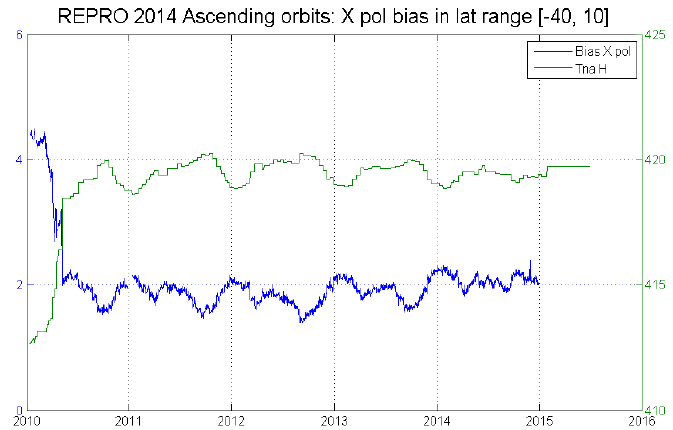
Figure 2. Bias of the Xpol SMOS measurements for ascending orbits over the Pacific Ocean (blue) for the period 2010–2015 and the NIR calibration parameter Tna (green). A computation of the correlation factor between the two variables is provided in Table 1. Table 1. Correlation factor between brightness temperature bias as computed over the ocean and NIR calibration parameter Tna.